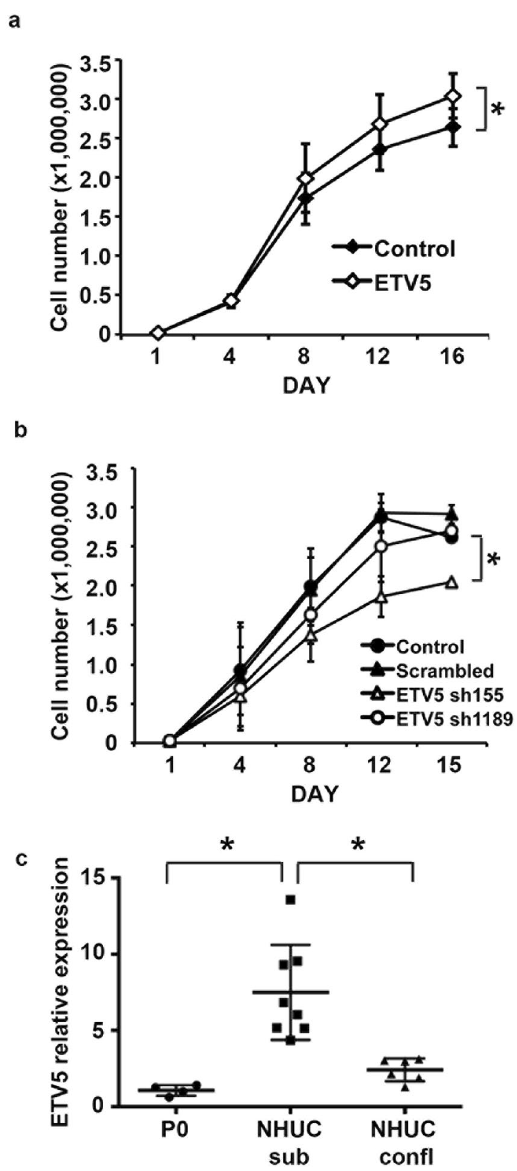
Figure 3. ETV5 expression and cell density of normal urothelial cells are mutually dependent. ( a ) Growth curves of TERT-NHUC overexpressing ETV5 and control cells transduced with the empty vector; ( b ) Growth curves of TERT-NHUC with knockdown of ETV5 (sh155 and sh1189), and control cells transduced with the empty vector (Control) or a scrambled shRNA; ( c ) mRNA relative expression of ETV5 in uncultured NHUC (passage zero, P0), and cultured mortal NHUC in sub-confluent (NHUC sub) and confluent conditions (NHUC confl). ETV5 mRNA expression levels were relatively quantified using Taqman Real-Time RT-PCR with SDHA as internal control. All experiments were repeated in triplicate. ‘ * ’ indicates a statistical significant difference between